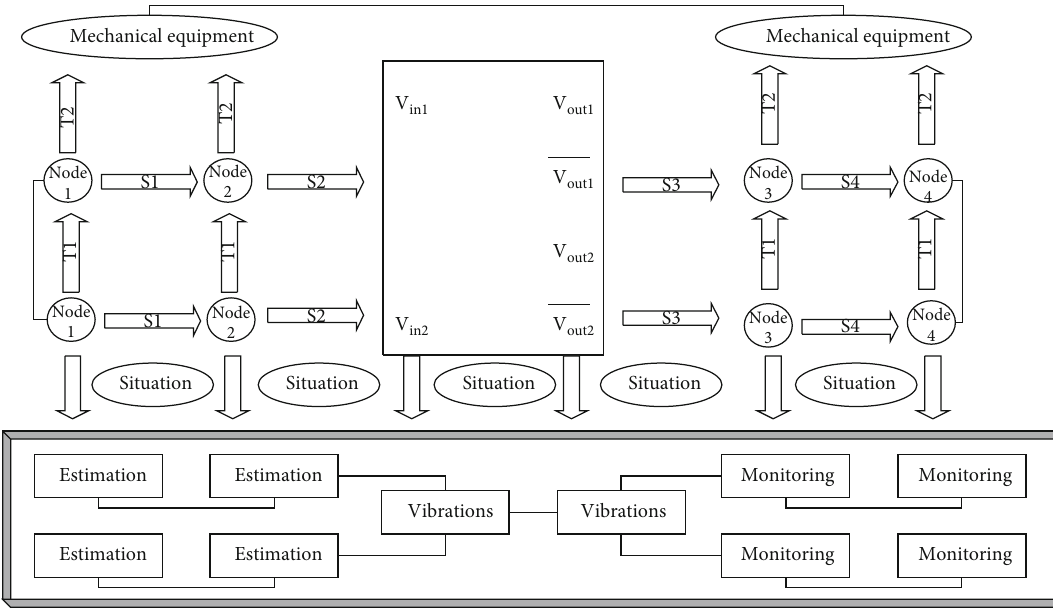
Figure 3: Mechanical equipment performance monitoring system